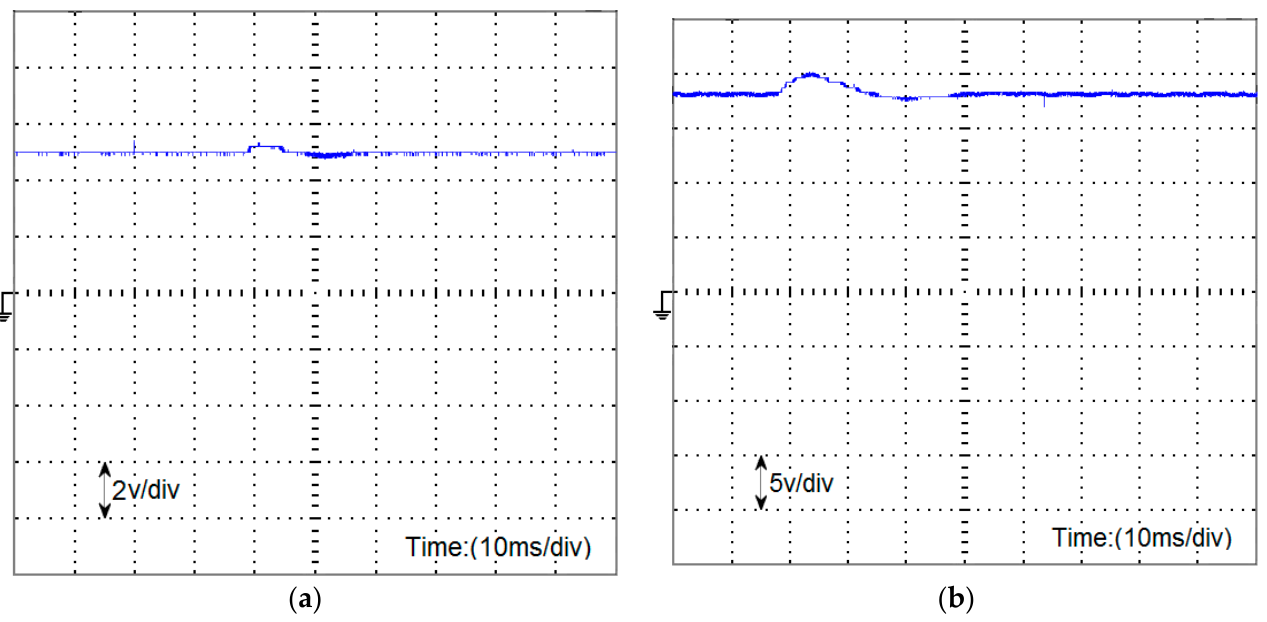
Figure 7. Experimental response of the proposed controller during load and line changes. ( a ) Re- sponse of the proposed controller during step changes of the input voltage from 12 V to 17 V (vertical scale is 2 V per square and time scale is 10 ms per square). ( b ) The output voltage of the converter during load changes in boost operating mode (vertical scale is 5 V per square and time scale is 10 ms per square).